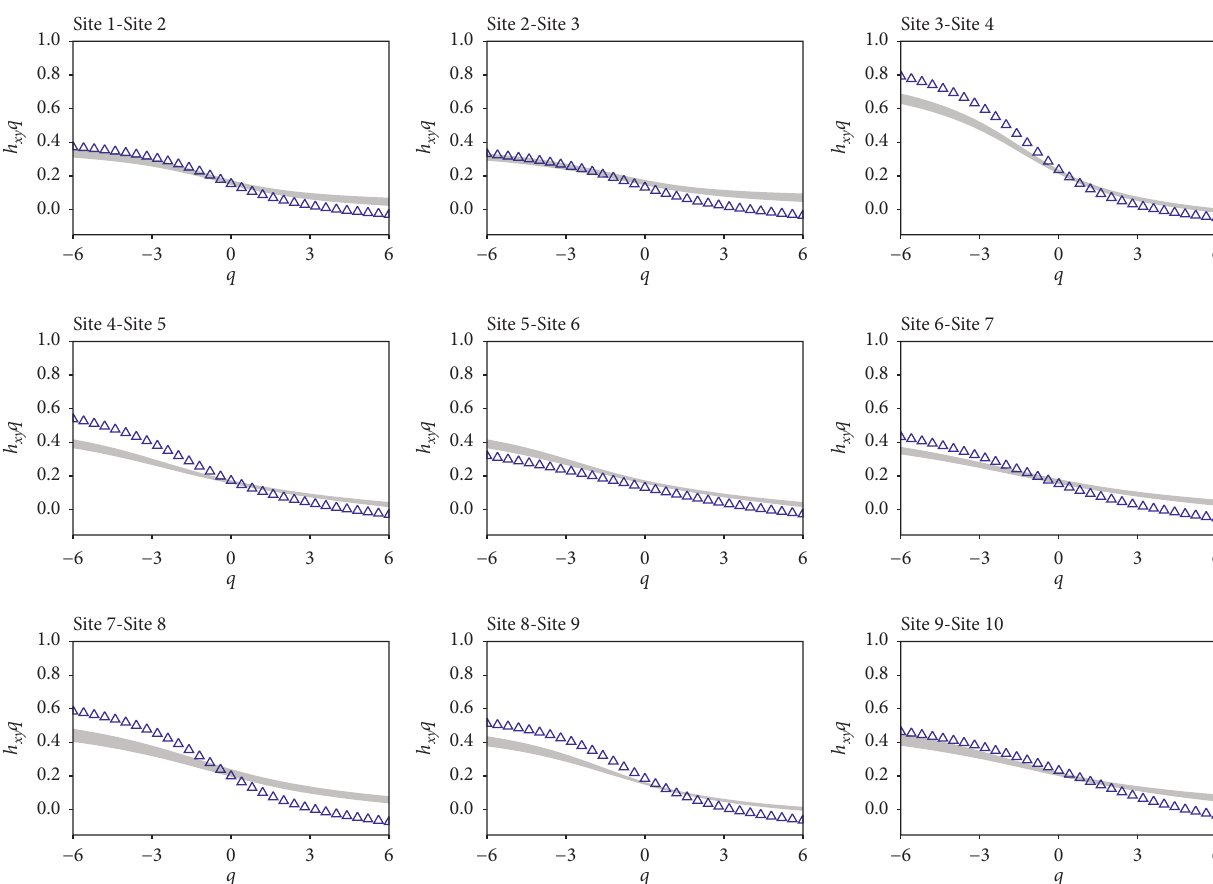
( t ) ,Y ( t )) 􏽮 􏽯 . X -axis denotes the range of q values. Triangles indicate h sg 2 sg 2 : the joint multifractality is not due to the fatness of probability 0 sg 2